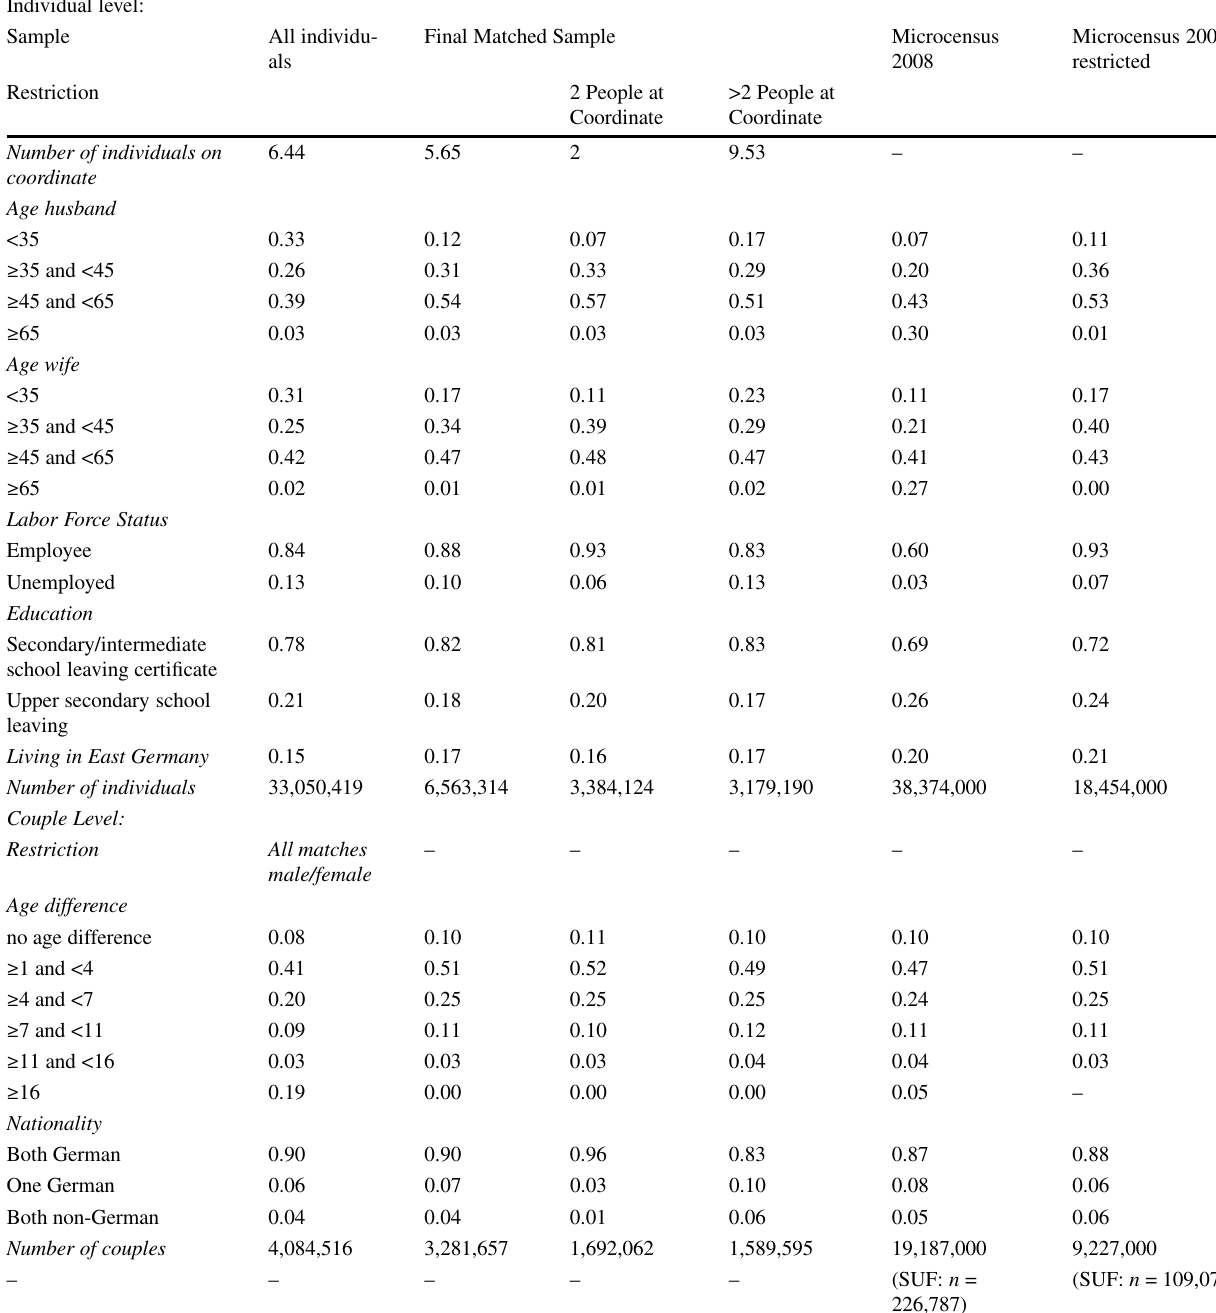
Table 6 Comparing Individuals and Couples with